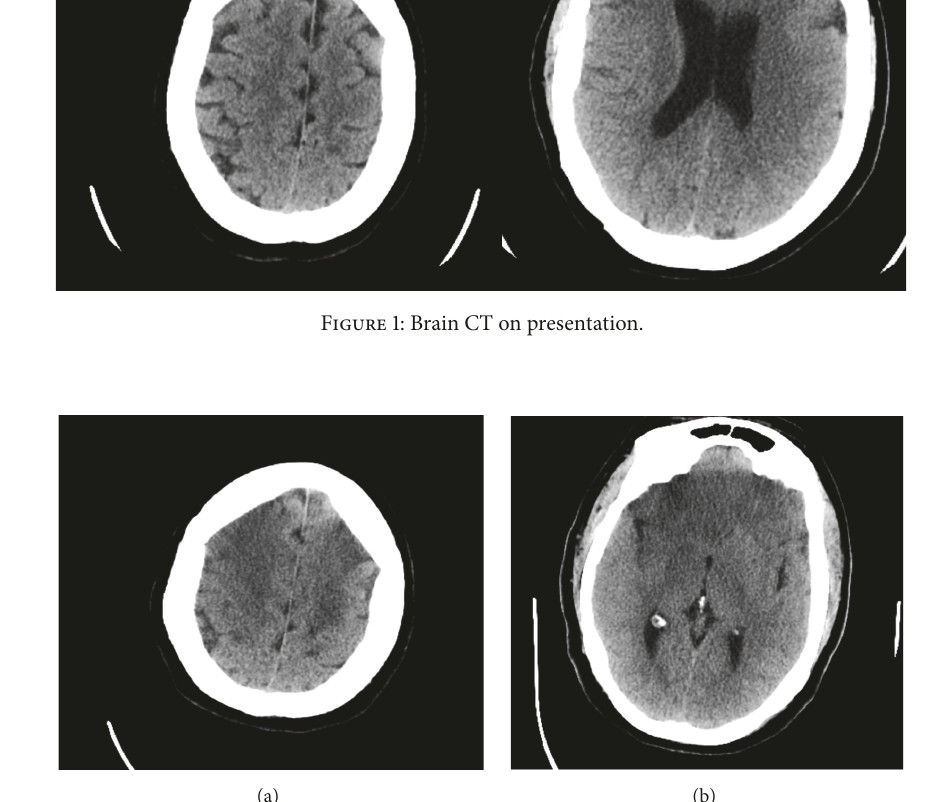
PCR, toxoplasma, west Nile virus, and oligoclonal bands.